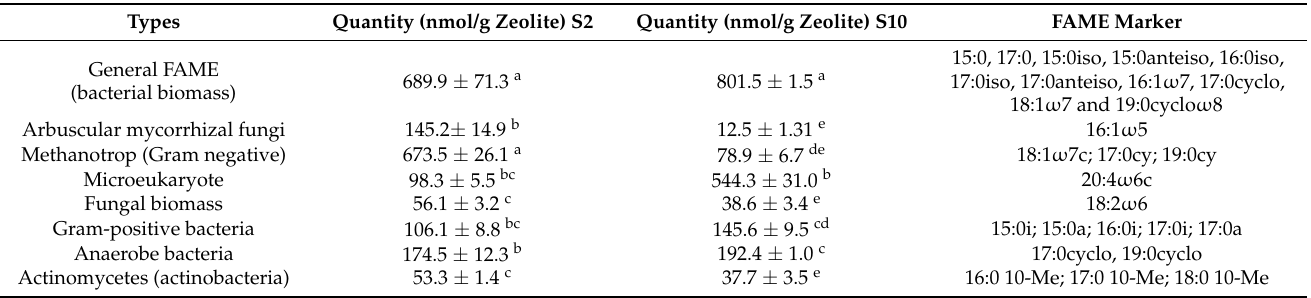
Table 5. The microbial community (data represent the mean ± standard deviation; n = 3; parallel